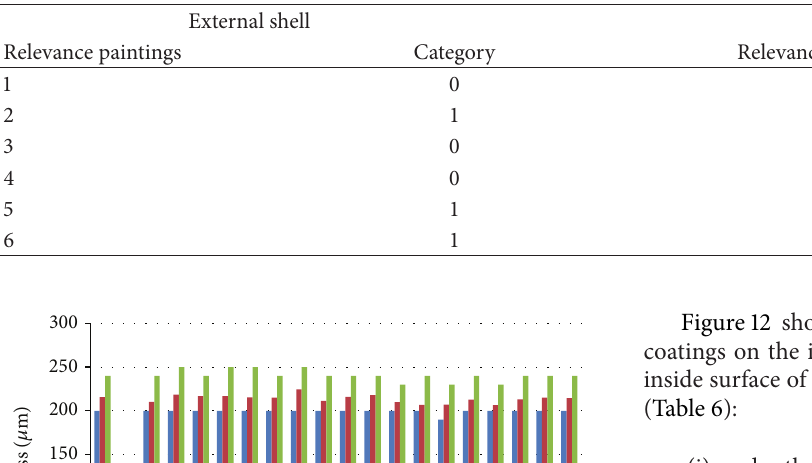
Table 4: Measurements of cross-cut for external and internal shell.